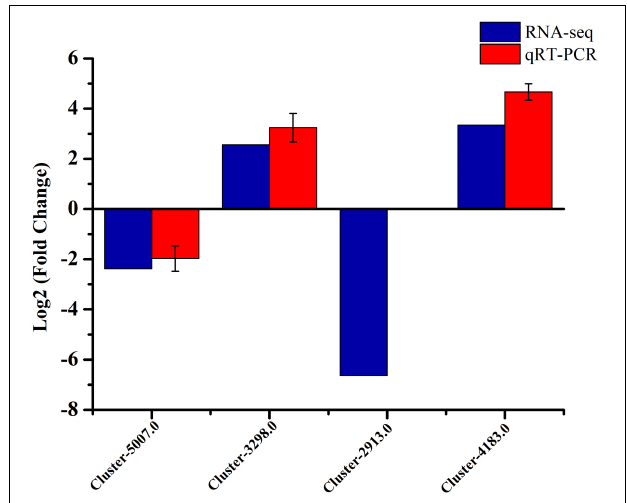
FIGURE 5 | qRT-PCR verification of the RNA-seq data of four selected DEGs in the strain MD33 and UN32. The blue columns represent RNA-seq data and the red columns represent qRT-PCR validation result. Values of qRT-PCR validation are presented as the log2 (fold change) ±